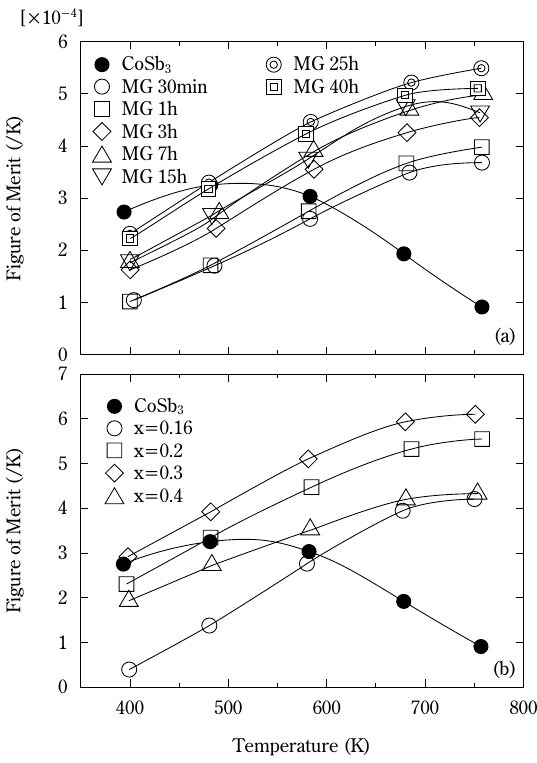
Fig. 11 (a)Seebeck coefficient and (b)electrical resistivity for the CoSb 3 -FeSb 2 composite whose molar ratio of CoSb 3 to FeSb 2 is 0.8:0.2 as a function of the temperature and MG time.